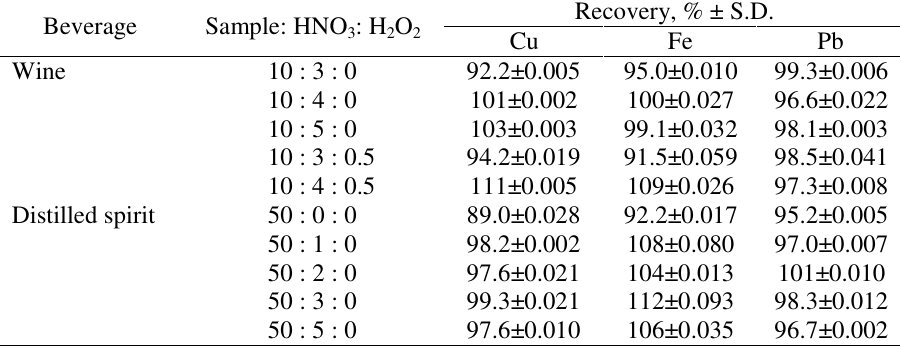
Table 3. Recovery of Cu, Fe and Pb in wine and distilled spirit samples using various ratios of sample and oxidizing agent ( n =